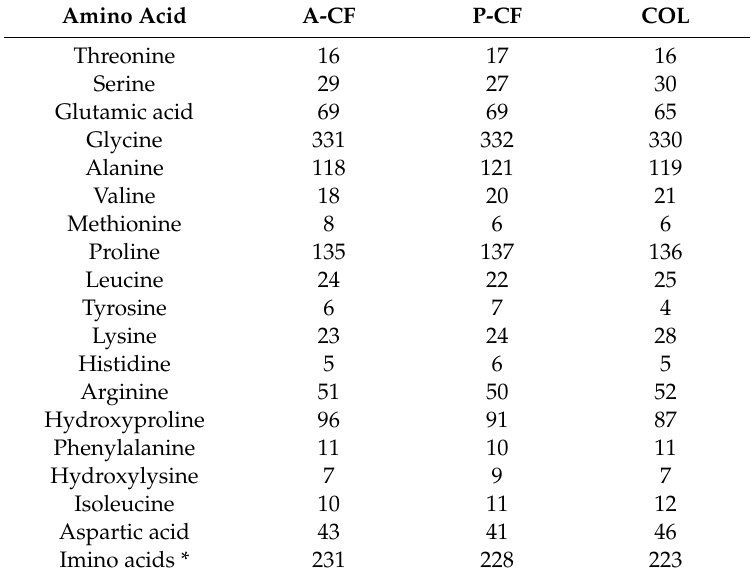
Table 1. Amino acid compositions of A-CF, P-CF and COL (residues / 1000 amino acid residues). Amino Acid A-CF P-CF COL Threonine